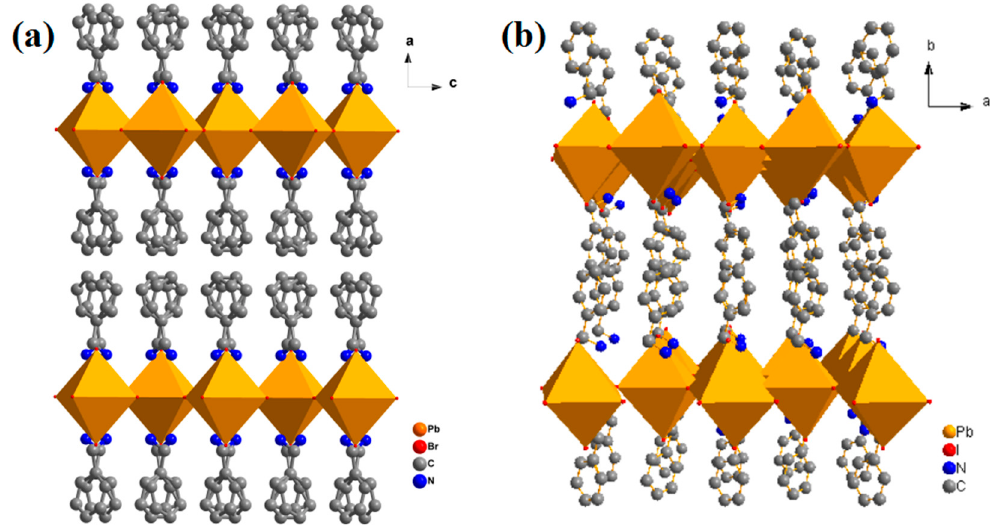
Figure 2. The crystal structure of the perovskites ( a ) (C 6 H 5 CH 2 NH 3 ) 2 PbBr 4 ; ( b ) (C 6 H 5 CH 2 NH 3 ) 2 PbI 4 . The hydrogen atoms bonded to the carbon atoms are omitted for clarity.